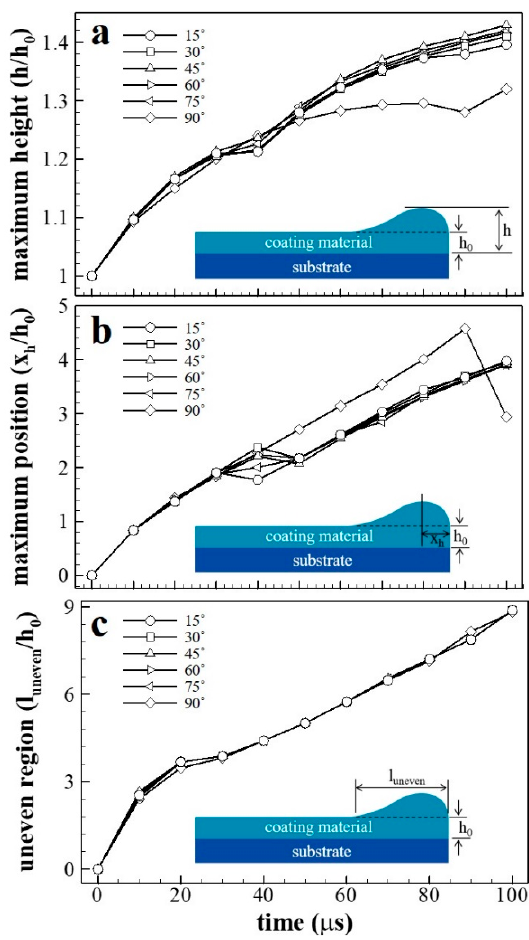
Figure 8. ( a ) Maximum height, ( b ) maximum position, and ( c ) uneven region analysis of the surface unevenness at the edge of the substrate with different wetting conditions.